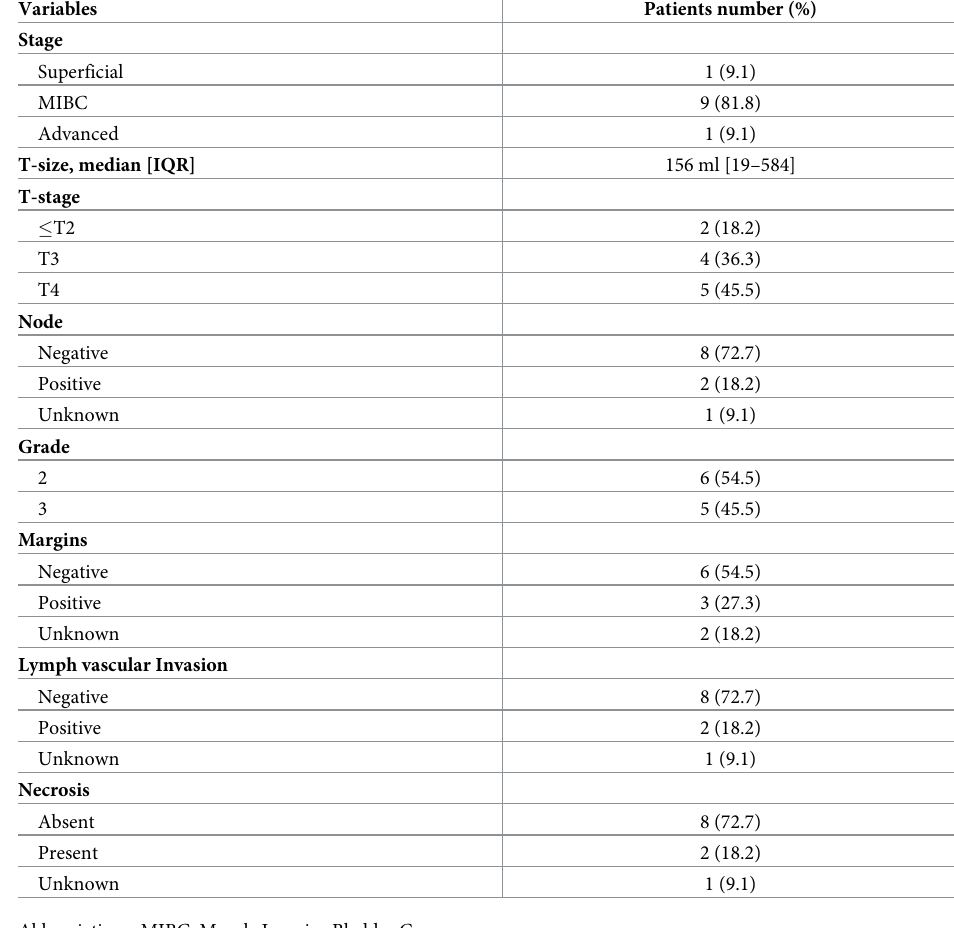
Abbreviations: MIBC, Muscle Invasive Bladder